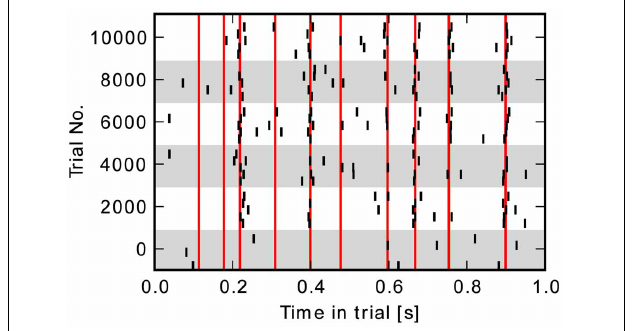
FIGURE 3 | Raster-plot of output spike-events for all five neurons at intervals of 2000 trials. Red bars indicate the target firing